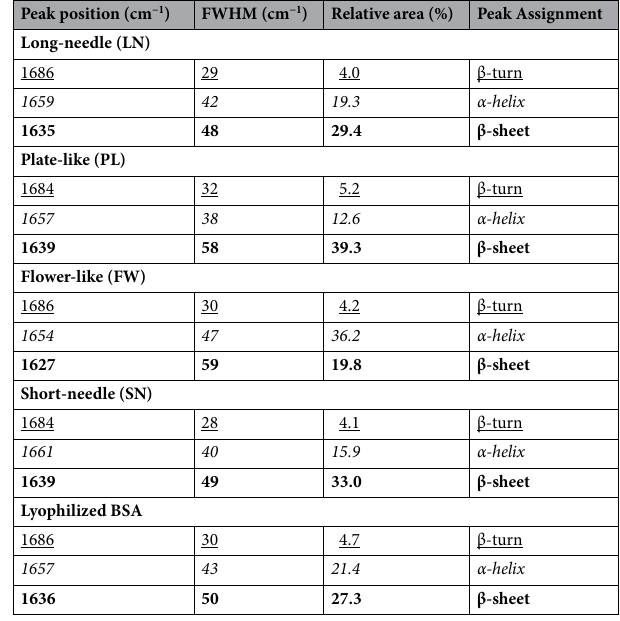
Table 1. Summary of peak positions, full-width-at-half-maximum (FWHM) values, and % relative areas of β-turn (underlined), α-helix (italicized), and β-sheet (bolded) structural motifs in the Amide I region of BSA absorbed on various HA/CHA microstructures and in control on lyophilized BSA.